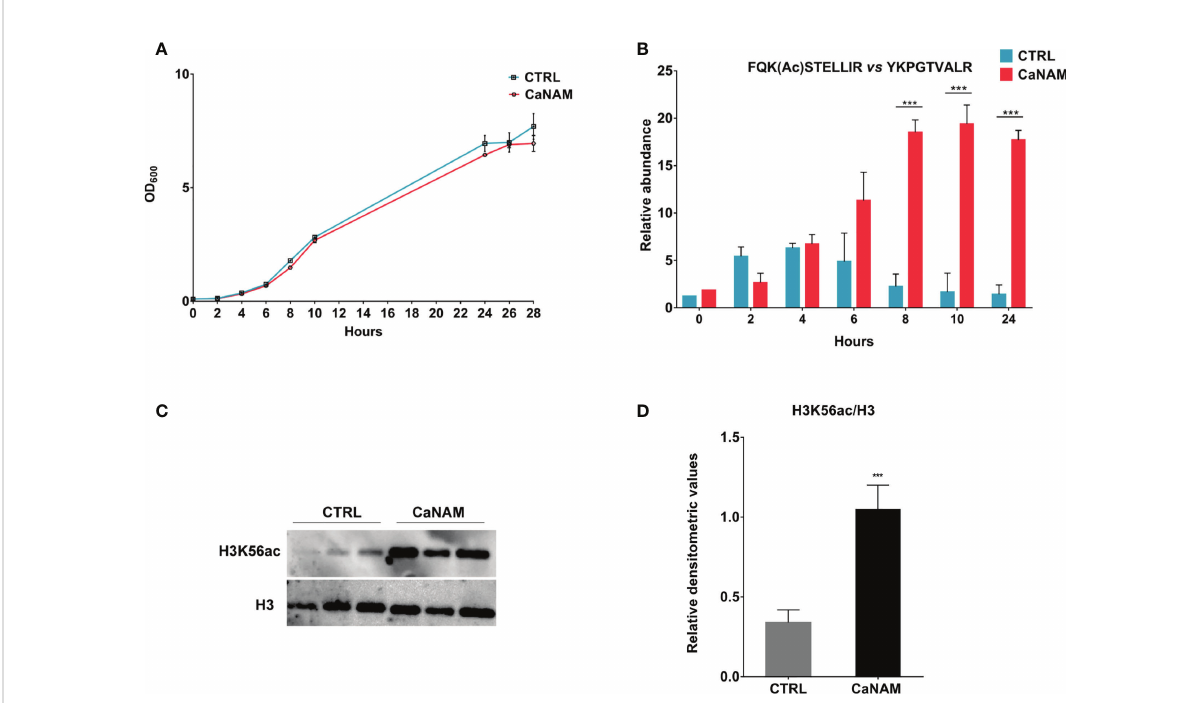
FIGURE 1 H3K56 acetylation levels during C. albicans growth. (A) Comparison of the growth curve of Candida yeast control versus treated with 10 mM NAM. (B) Quantitation of H3K56ac levels during C. albicans growth, with and without 10 mM NAM by Nano LC-MS/MS. (C) Representative Western Blot showing H3K56ac accumulation after 28h of treatment with 10 mM NAM. (D) Densitometric analysis of H3K56ac normalized to H3 from three independent experiments as in (C) . Values are mean ± standard error of three independent experiments ***p<0.001